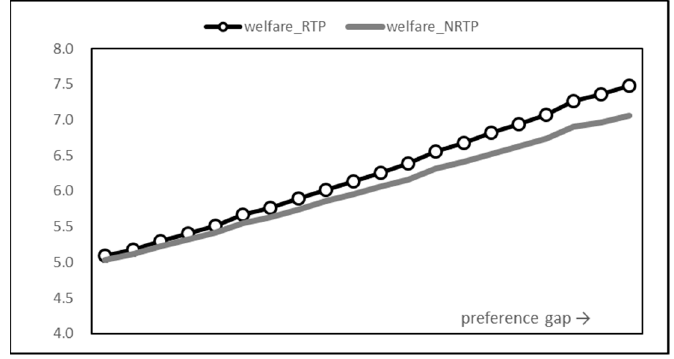
Figure 16. Social welfare graph.